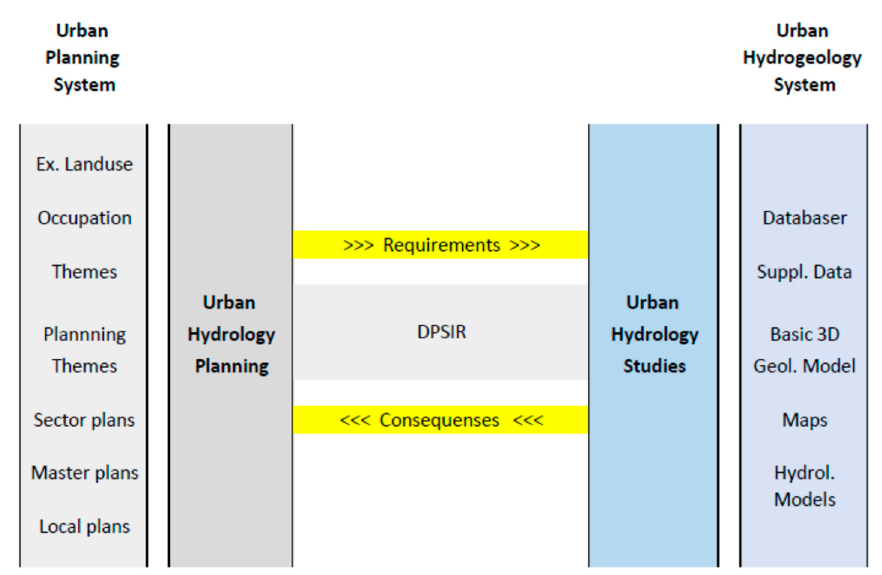
Figure 12. Interaction between Urban Planning System and hydrogeological studies in a City-Scale Hydrogeological Framework. Urban planning contributes with requirements, and hydrogeologists deliver consequences—in a continuous Driver-Pressure-State-Impact-Response (DPSIR) loop until a solution is found.